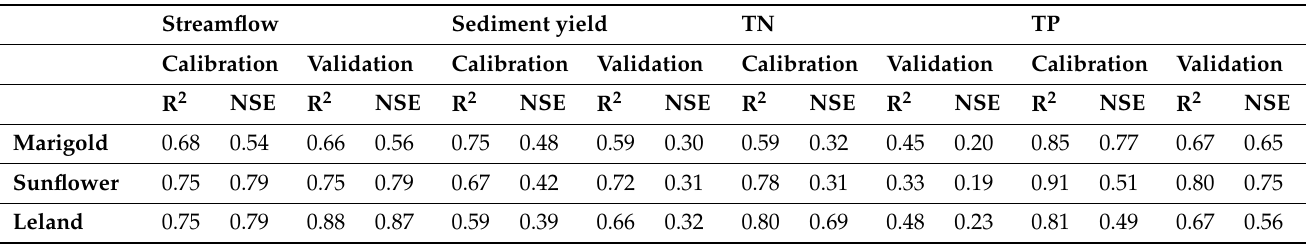
Table 1. Calibration and validation statistics for streamflow, sediment, TN and TP load at three USGS gauges of BSRW.